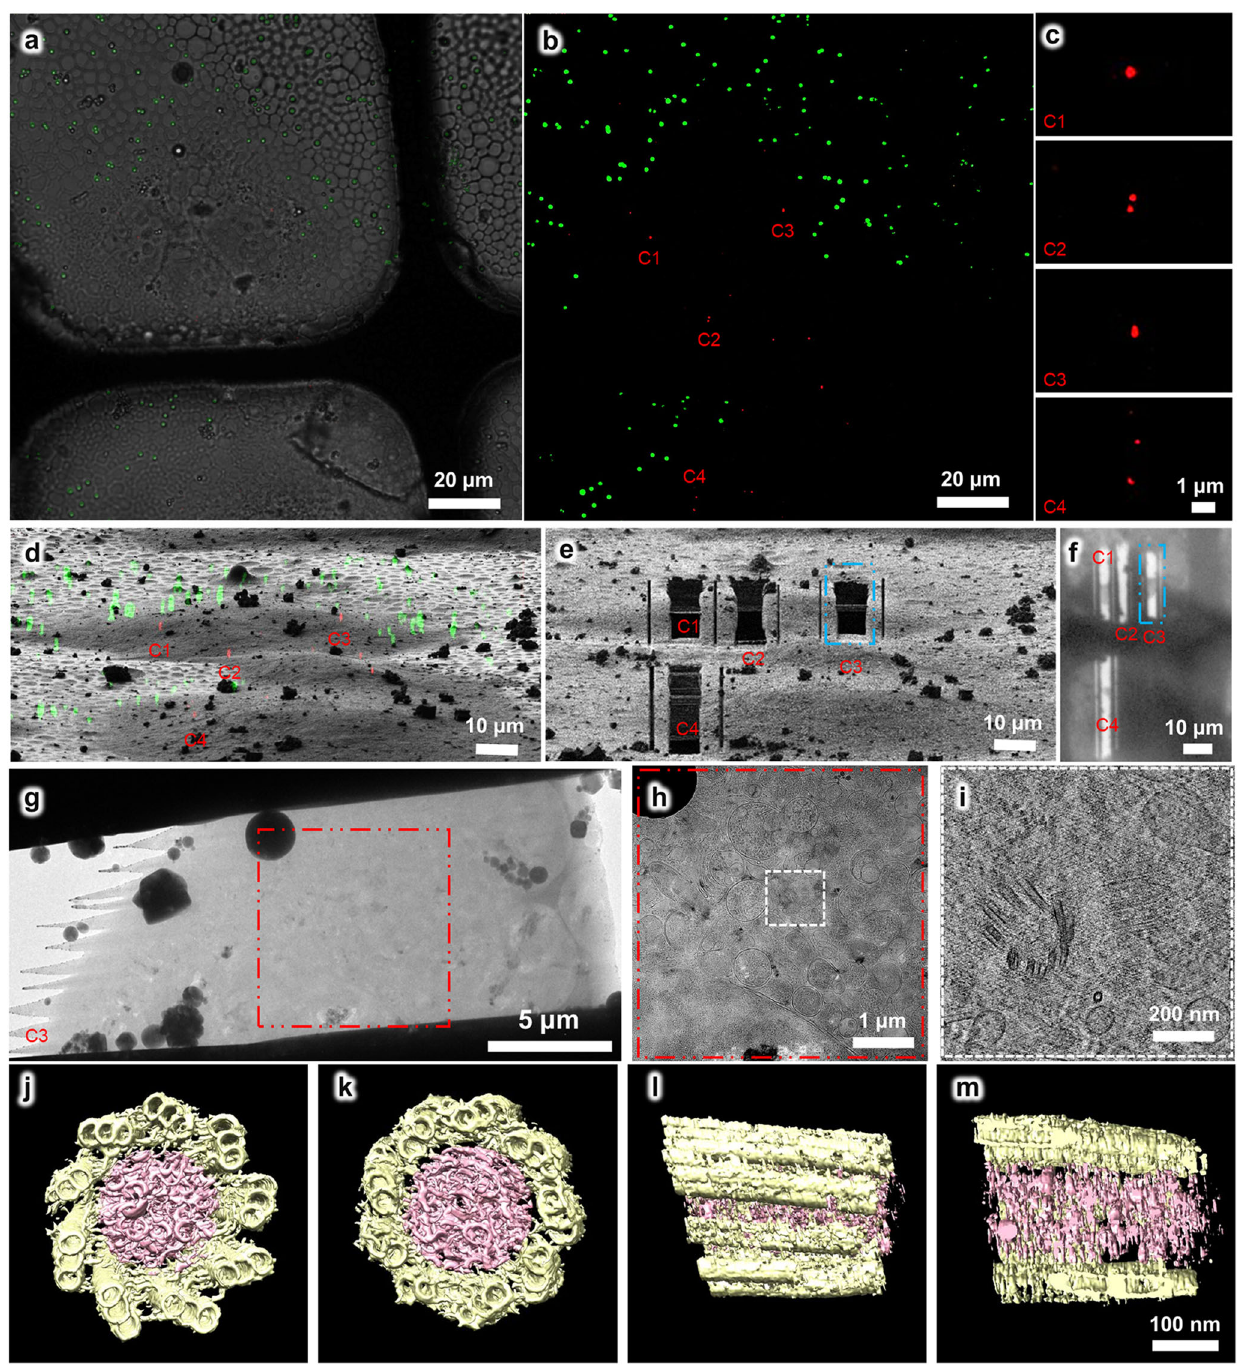
Fig. 5 Using the HOPE-SIM-based cryo-CLEM work fl ow to capture the centrosomes in HeLa cells. a Bright- fi eld image of the target square is merged with the z projection of HOPE-SIM fl uorescent image in ( b ), where the microspheres (green) are well spread, and the fl uorescence-labeled centrosomes (red) are well resolved. Four sets (C1-4) of centrosomes are selected C1-4 for subsequent cryo-FIB fabrication. c Zoomed-in view of the four sets of centrosomes in ( b ). d 3D correlation between HOPE-SIM and cryo-FIB images to localize the positions of the selected centrosomes. e Cryo-FIB image after fabrication at the positions of C1-4 in ( d ). The cryo-lamella C3 indicated by the blue dashed rectangle is subjected to cryo-ET data collection. f Low-magni fi cation (×155) cryo-EM image of the cryo-lamellae in ( e ). g Cryo-EM micrograph of the C3 cryo-lamella with the magni fi cation of ×4300. h Cryo-EM micrograph (×8700) of the C3 cryo-lamella at the region of the red square in ( g ). The target region marked by the white square is subjected for cryo-ET data collection and reconstruction. i One slice of the tomogram (×53,000) of the target region, showing the target centrioles with one in the top view and another in the side view. j – m 3D in situ structure of the centriole in HeLa cells with different views, ( j ) top, ( k ) bottom, ( l ) side, and ( m ) cross. The structure is segmented using EMAN2 61 and rendered in Chimera 62 . The triplet tubules are shown in yellow, and the internal scaffold structures are shown in pink. To be noted, this structure was derived from another tomogram (×26,000) of cryo-lamella with a thickness of ~300 nm. See Supplementary Data 7 for raw cryo-FIB images of ( d ) and ( e ), and raw cryo-EM image of ( f ).